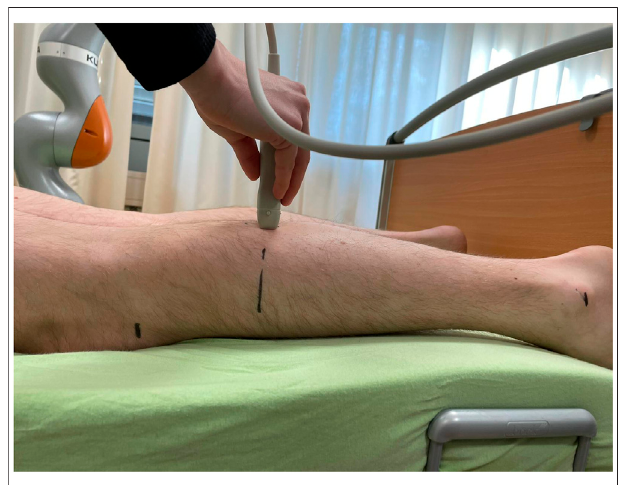
FIGURE 3 | Sonography to investigate muscle thickness in the calf